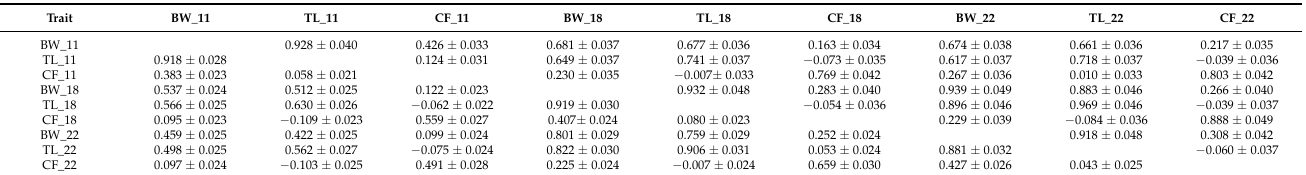
Table 3. Genetic correlations (above diagonal) and phenotypic correlations (below diagonal) among olive flounder ( Paralichthys olivaceus ): BW, TL, and CF traits in 3 periods of time ( ± SE ).